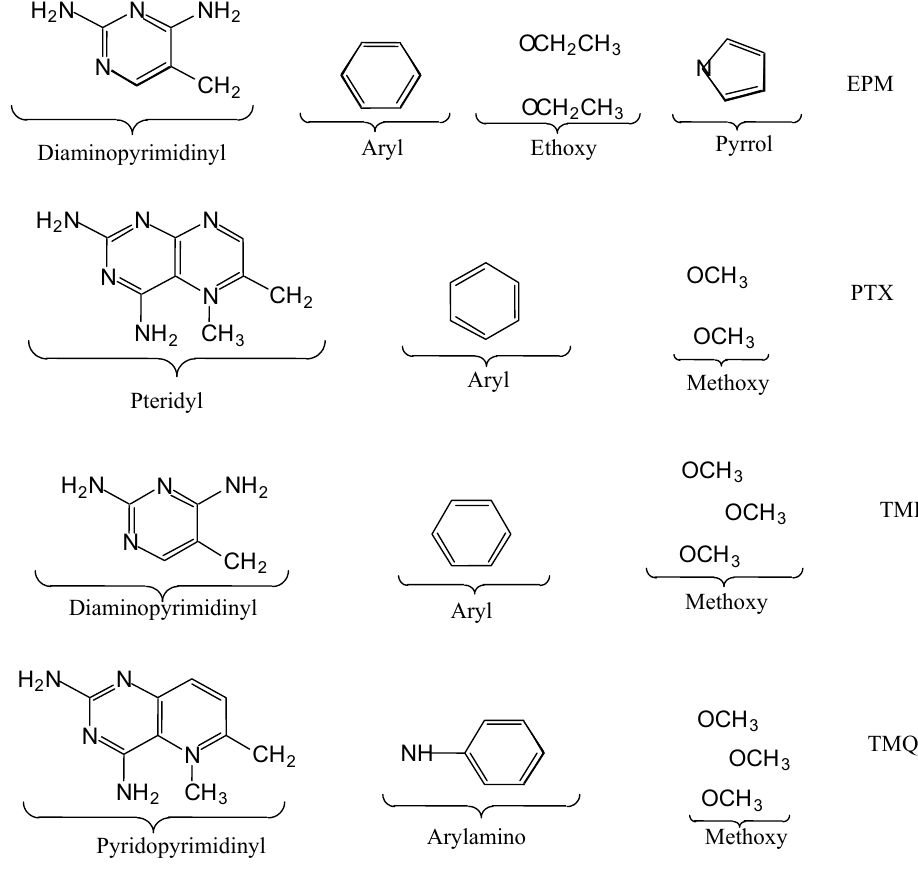
Figure 1. Substructural regions of EPM, PTX, TMP, and TMQ.